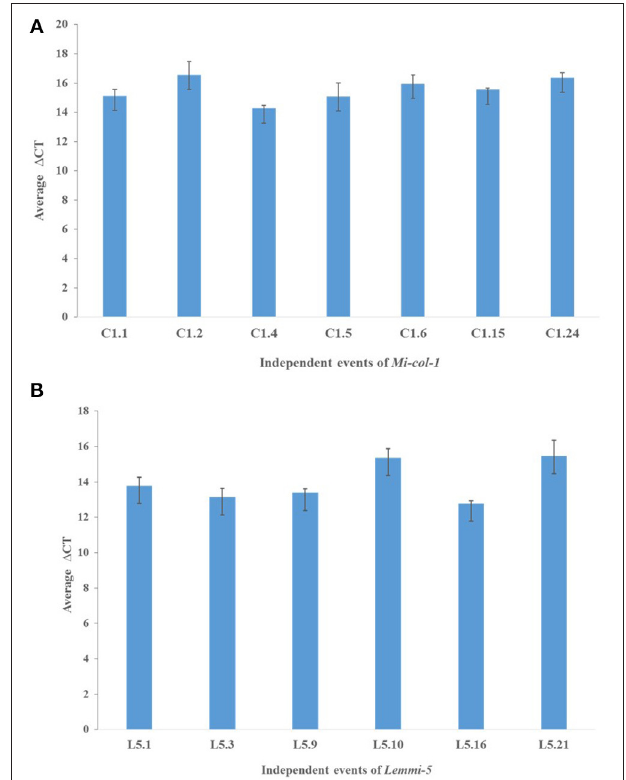
FIGURE 6 | Expression analysis of (A) Mi-col-1 and (B) Lemmi-5 dsRNAs in their respective transgenic tomato events using qRT-PCR. 18s rRNA ( S. lycopersicum ) gene has been used as an internal control. Each bar represents the mean ± SE of n =